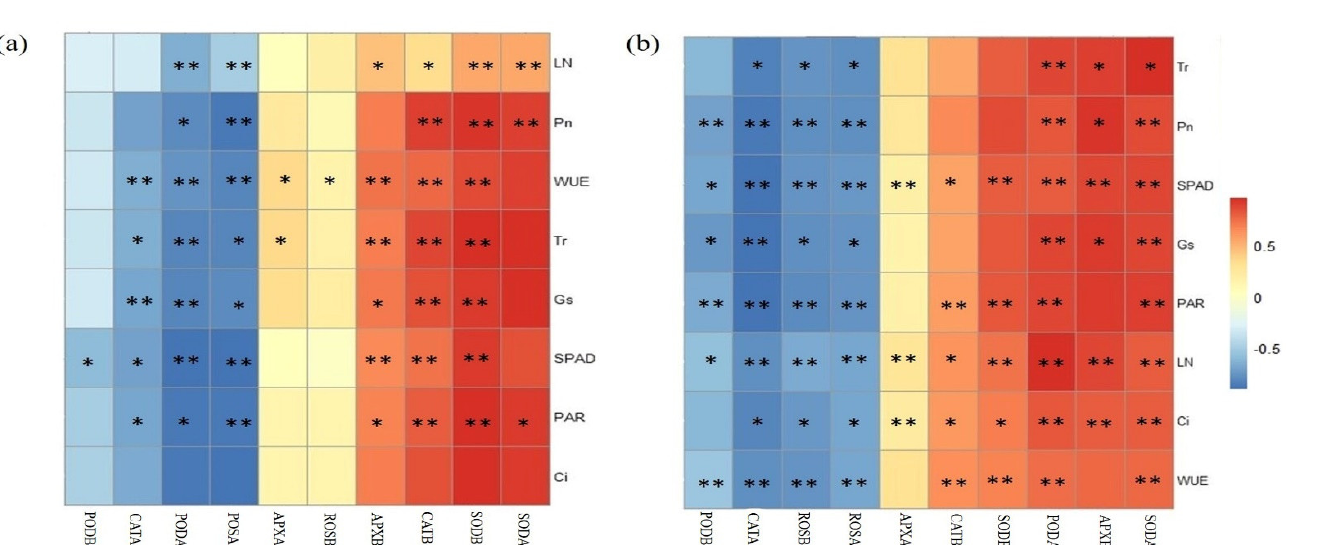
Figure 2. Redundancy analysis (RDA) of the antioxidant enzyme and biomass representing at the ( a ) 50th and ( b ) 80th days after transplanting, while the in-between antioxidant enzyme and photosynthetic parameters are represented at the ( c ) 50th and ( d ) 80th days after transplanting of the rice crop. CK = control treatment; SI = Solidago canadensis L. invasion treatment; MPs = soil microplastics residual treatment; SI × MPs = combination of S. canadensis invasion treatment and soil microplastics residual treatment; RB = root biomass; SB = stem biomass; TB = total biomass; Pn = net photosynthetic rate; Tr = transpiration rate; Gs = stomatal conductance; PAR = photosynthetically active radiation; Ci = intracellular CO 2 concentration; WUE = water-use efficiency; Leaf N = leaf nitrogen; APXB = ascorbate peroxidase in belowground; APXA = ascorbate peroxidase in aboveground; CATB = catalase in belowground; CATA = catalase in aboveground; PODB = peroxidase in belowground; PODA = peroxidase in aboveground; SODB = superoxide dismutase in belowground; SODA = superoxide dismutase in aboveground; ROSB = reactive oxygen species in belowground; ROSA = reactive oxygen species in aboveground.